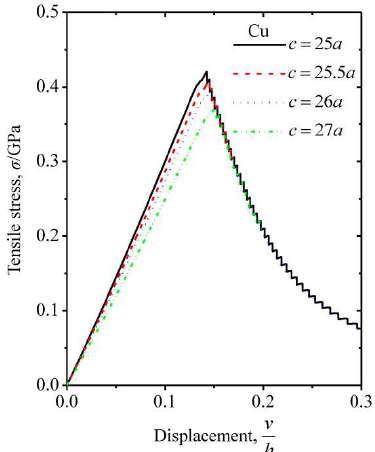
Figure 2. Tensile stress (  ) of Cu nanoplates as a function of v / h for four lengths of edge crack: c = 25 a , 25.5 a , 26 a , and 27 a .   is defined as the average value of the atomic stress (  22 ) over the entire volume 25.5 a , 26 a , and 27 a . σ is defined as the average value of the atomic stress ( σ 22 ) over the entire volume of of the simulation system. the simulation